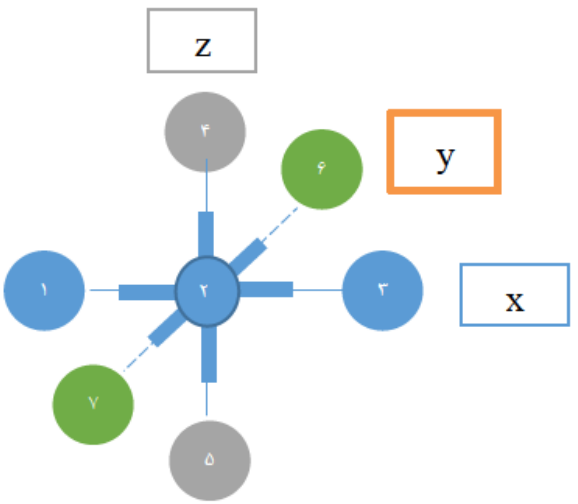
Figure 2: Three-dimensional nanobot